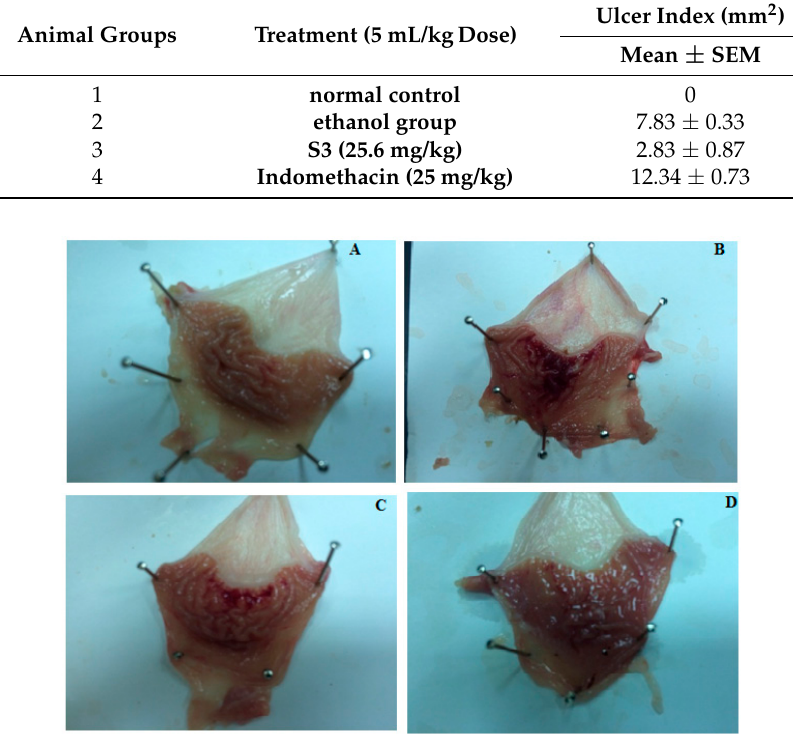
Figure 1. ( A ) Gastric sections of control rats showing normal mucosa. ( B ) Gastric section of untreated rats showing mucosal ulceration. ( C ) Gastric section of compound S3 treated rats (25.6 mg/kg) showing intact mucosa with mild ulceration ( D ) Gastric section of indomethacin-treated rats (25 mg/kg) showing focal mucosal ulceration. Molecules 2018 , 23 , x FOR PEER REVIEW